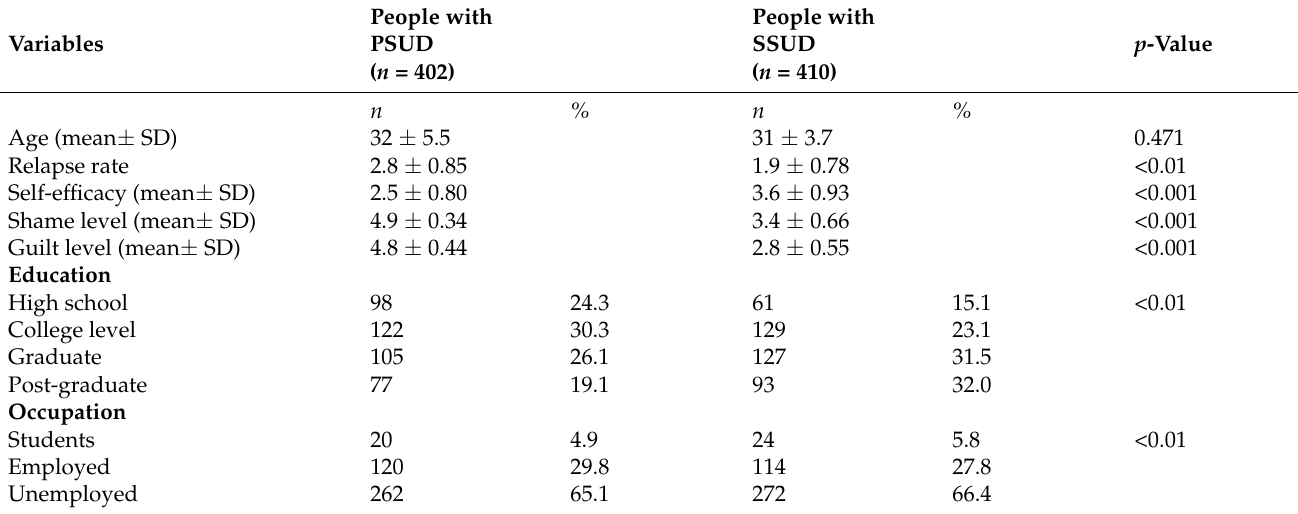
Table 1. Sociodemographic characteristics between the people with PSUD and